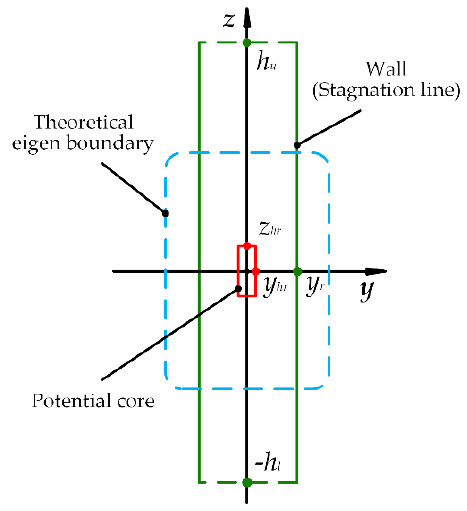
Figure 4. Critical section of deflector action.